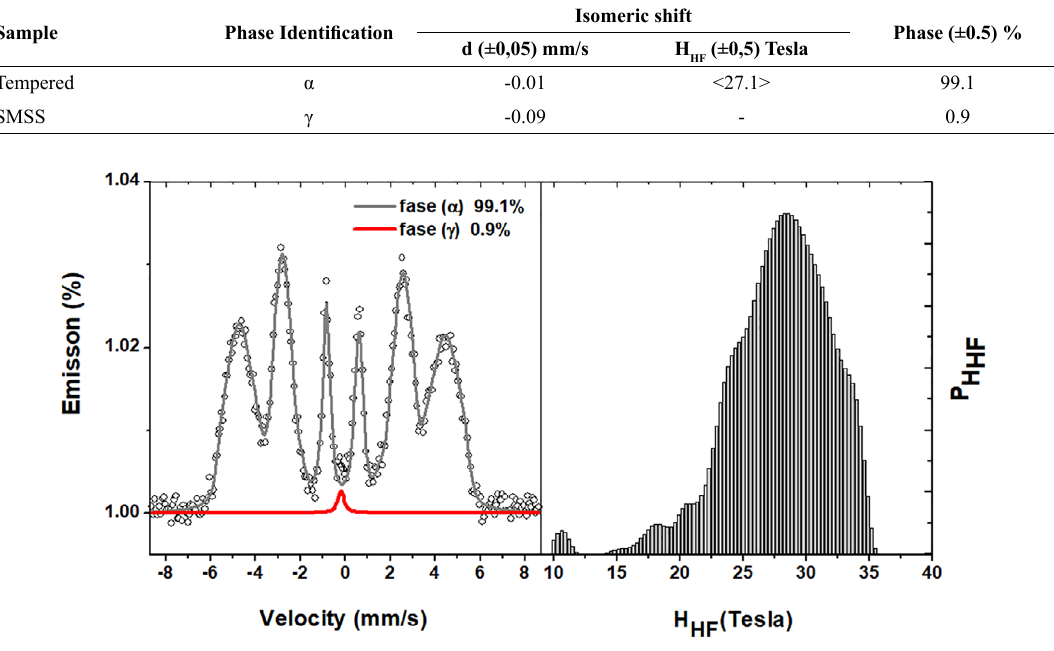
Figure 5. Mössbauer spectroscopy results of tempered SMSS.